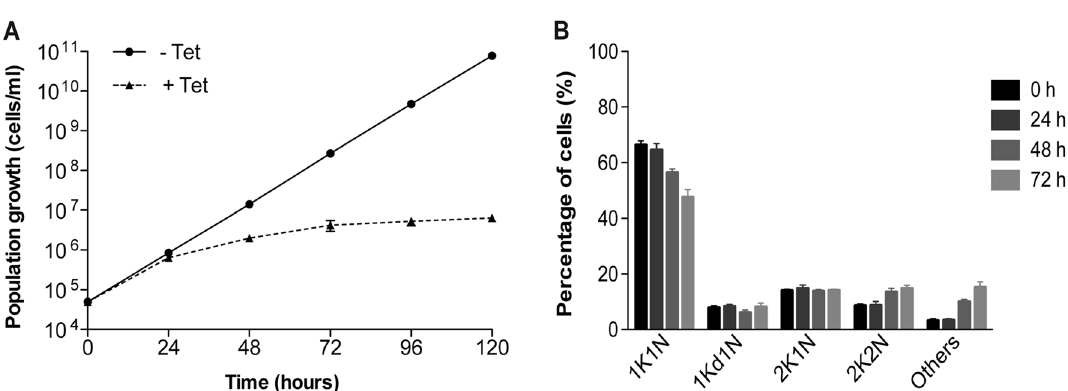
Figure 3. Hel66 is essential in BSF T. brucei ( A ) Growth curves showing cumulative cell numbers of uninduced (-Tet) and induced (+ Tet) Hel66-RNAi cells. Data are averages from three clonal cell lines with error bars representing means ± standard error of the mean (SEM). ( B ) Cell cycle analysis at different time points during Hel66 depletion. Cells were stained with DAPI and classified to the different cell cycle stages according to the number of nuclei (N) and kinetoplasts (K). As the kinetoplast divides prior to the nucleus, 1K1N, 2K1N and 2K2N stages corresponding to different cell cycle states can be distinguished. 1Kd1N is a precursor stage of 2K1N cells, with the kinetoplast in division. 200 cells were analysed at each timepoint in three clonal cell lines and plotted as mean percentages ±